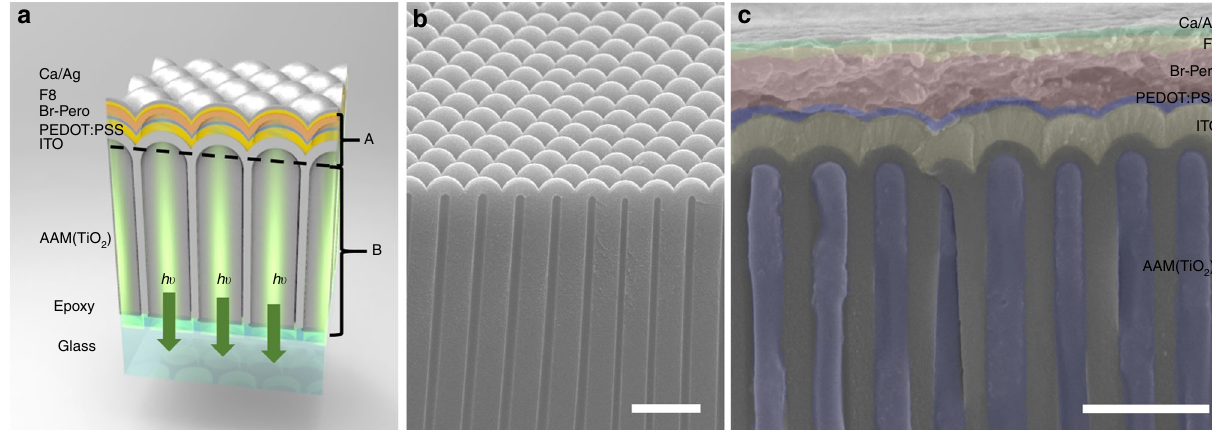
Fig. 1 Device on nanophotonic substrate. a Device schematic. The materials from top to bottom are: Ca/Ag electrode, F8, CH 3 NH 3 PbBr 3 (Br-Pero), PEDOT: PSS, ITO, and anodic alumina membrane (AAM). AAM channels are fi lled with TiO 2 . b SEM image of the barrier side of the free-standing AAM fi lm with nanodomes structures. c Cross-sectional SEM image of a P500 AAM device. Scale bars in b and c are 1